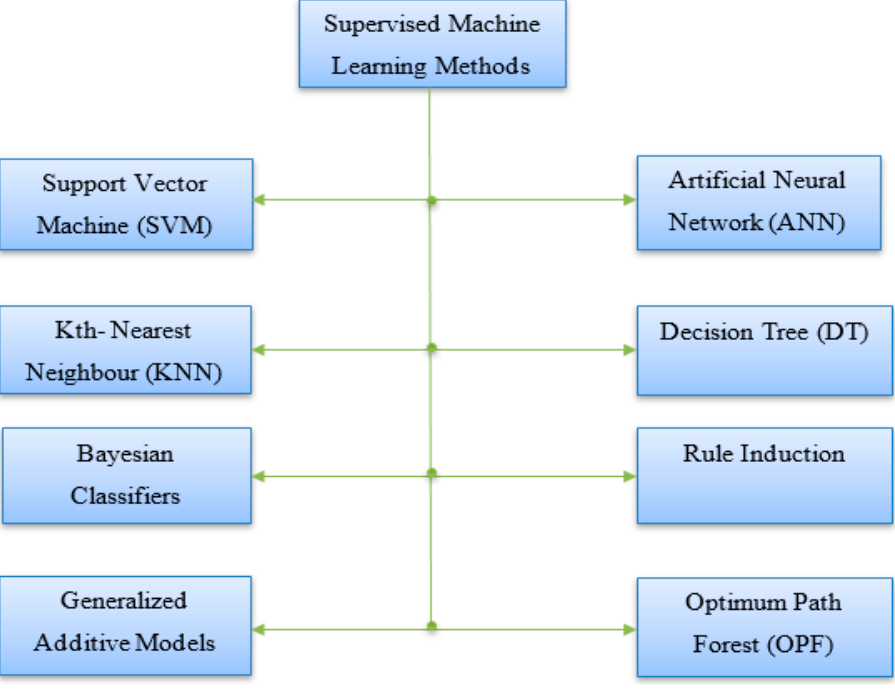
Figure 3. Supervised machine learning algorithms for NTL detection problems .